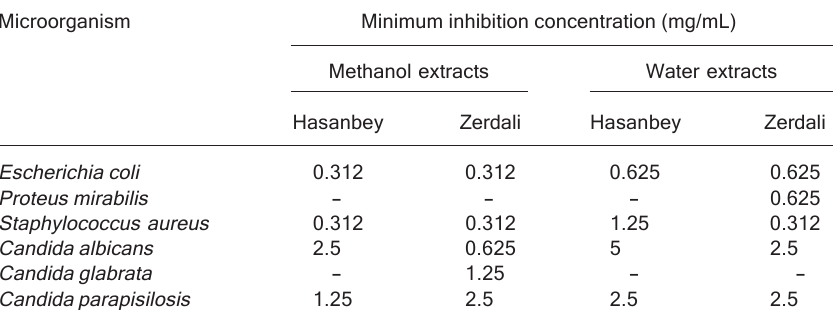
- = extract not tested. MIC values of positive controls ranged from 0.12 to 1 μ g/mL for 5 μ g ofloxacin, 0.12 to 0.5 μ g/mL for 105 μ g cefaperazone, and 0.5 to 1 μ g/mL for 30 μ g amphoteri- cin B,